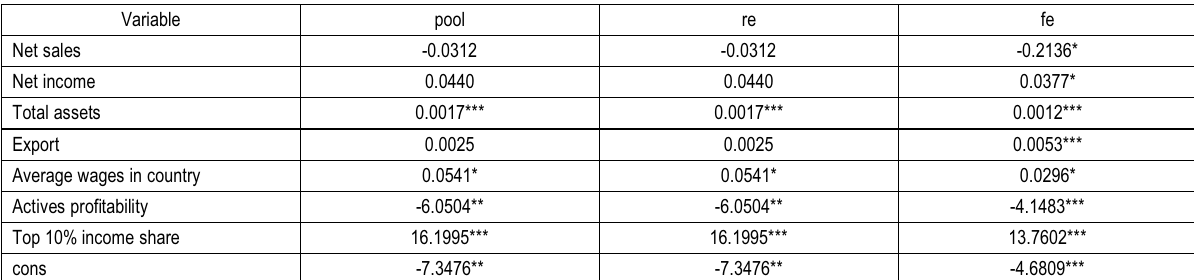
Table 2. Regression